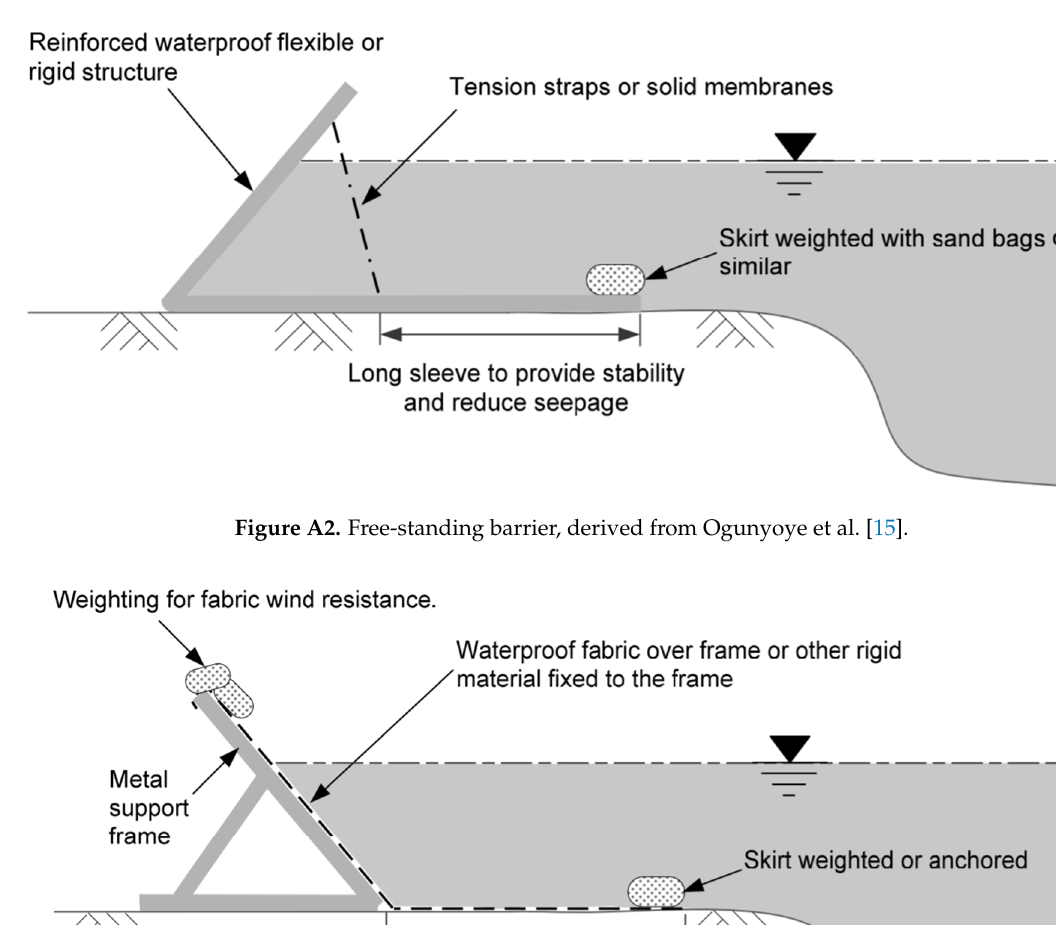
Figure A4. Panel barrier, derived from Ogunyoye and van Heereveld [6]. References 1.